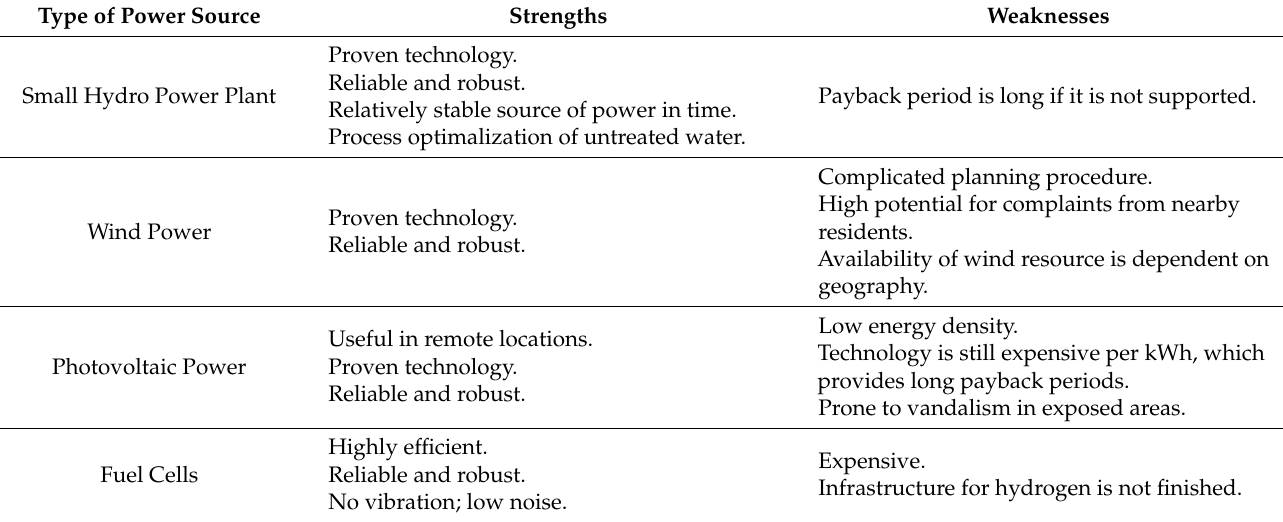
Table 5. Strengths and weaknesses of the renewable power